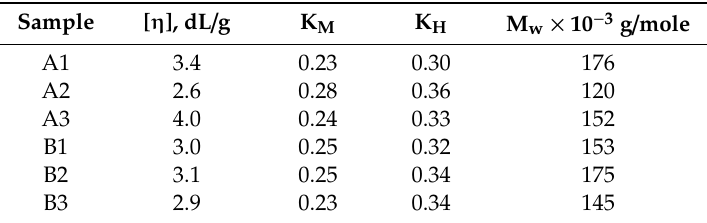
Table 2. Molecular characteristics of the synthesized